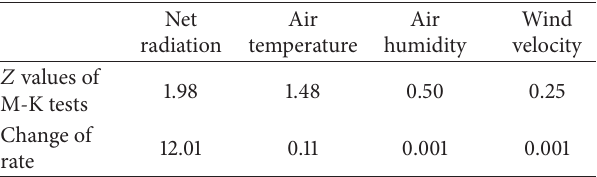
Table 3: 𝑍 values of M-K tests and contribution ratios for annual air drying force and radiation driving force in Dongping Lake during